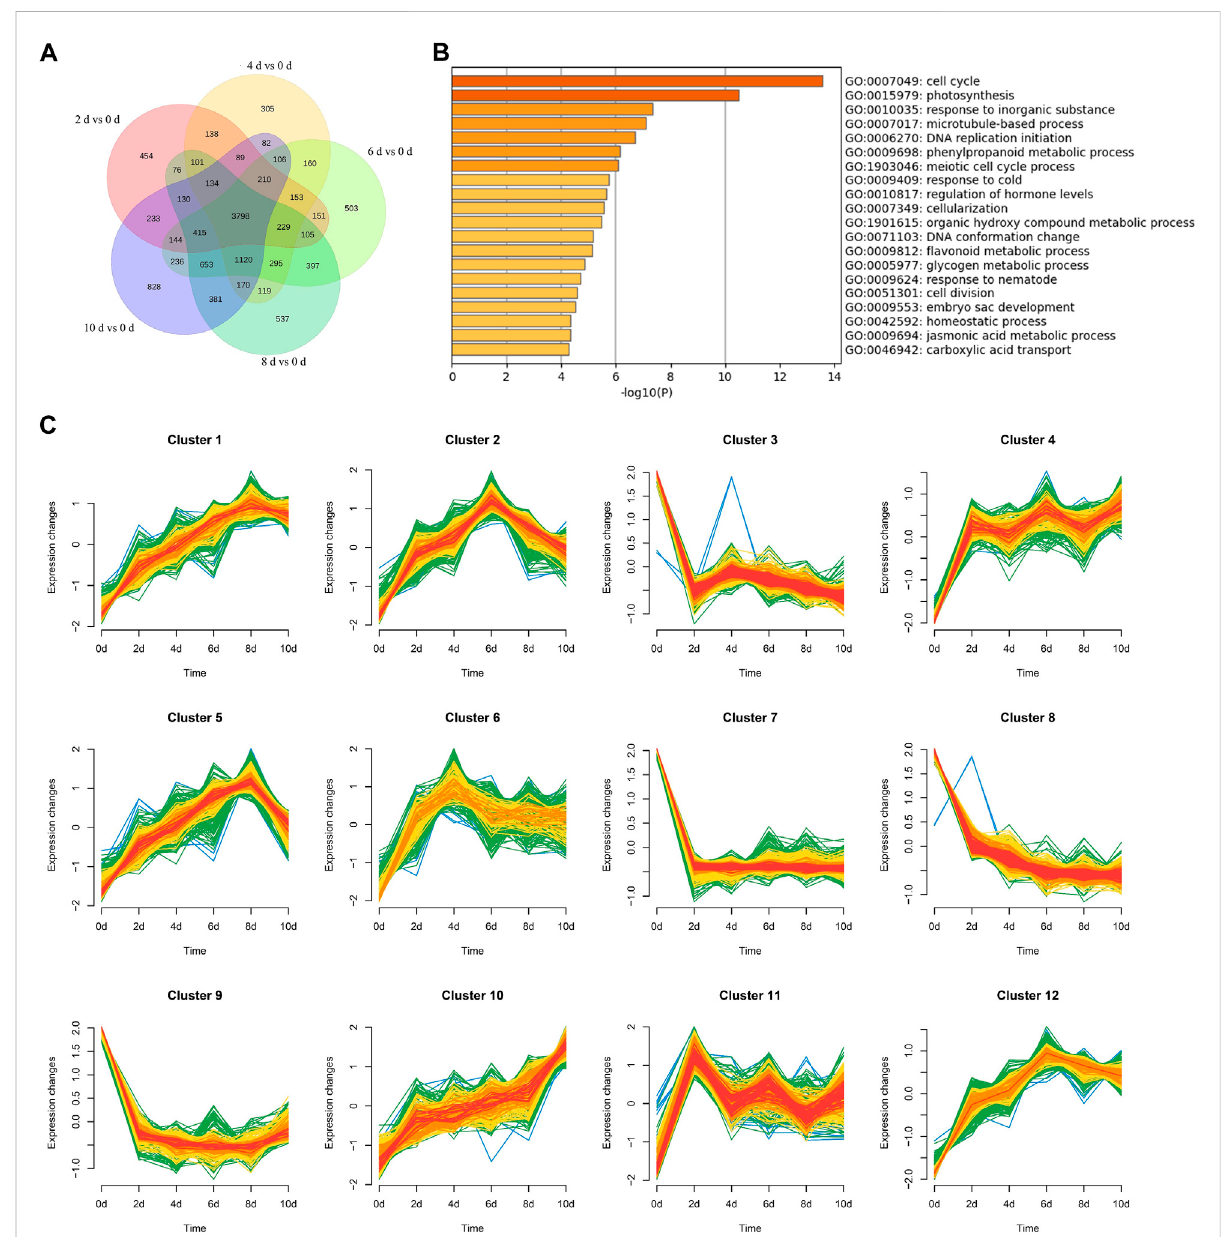
FIGURE 2 Venn maps, Go analysis, and clustering analysis of common DEGs. (A) 0 d as control. Number of DEGs between 0 d and different days. (B) Go analysis of 3,798 common DEGs. Terms with a p -value < 0.05, Log10( p ) as enrichment standard. (C) Clustering analysis of 3,798 common